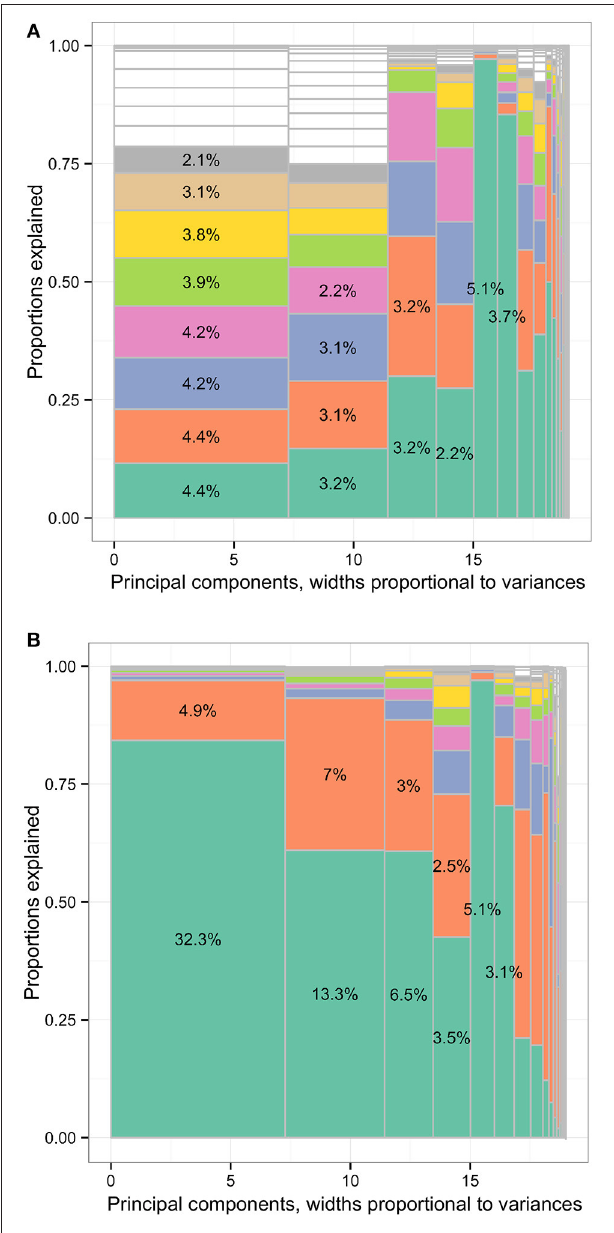
FIGURE 7 | The distribution of total variances by principal components and input variables or approximation variables in the Hitters data set. Principal components, widths proportional to variances. (A) The distribution of total variances by principal components and input variables. Principal components, widths proportional to variances. (B) The distribution of total variances by principal components and approximation variables. The percentages in the cells representing the percentages of variances relative to total variance (whole area) based on the loadings of principal component analysis (first charts) or R squared. Each column represented the principal components (PCs) and had widths the same as the PC variance. In each column, the cells were of unequal sizes representing the variances explained by the input variables. For each PC specified in each column, the PC was explained by input variables. The cells in each column represented the input variables. The cell sizes were proportional to how much the PCs were explained by input variables. The cells were